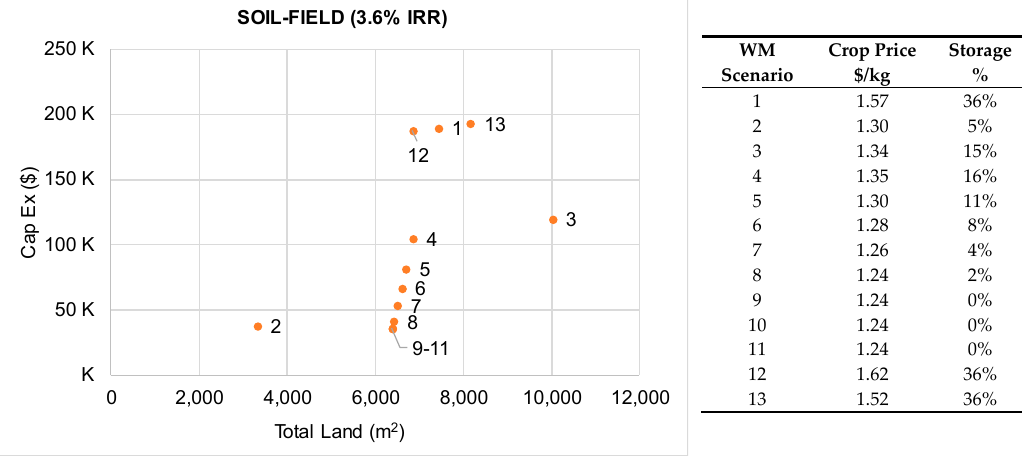
Figure 6. Soil-based system in field conditions (SOIL-FIELD) results for Adelaide (Parafield) climate.